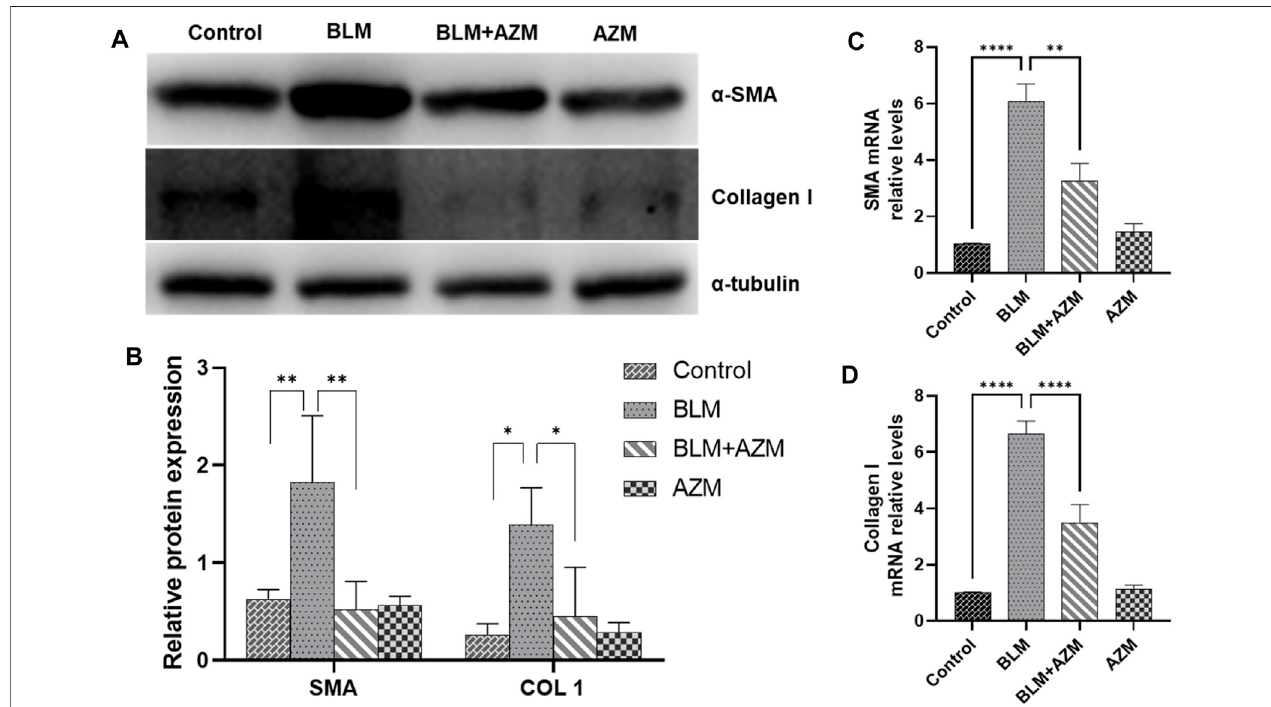
FIGURE 2 | AZM reduced the expression of alpha-smooth muscle actin ( α -SMA) and Collagen 1 (COL 1) in lung tissue of mice with pulmonary fi brosis. (A,B) The proteinexpressionof α -SMAandCOL1wasmeasuredineachgroupbyWesternblot. (C,D) Thegeneexpressionof α -SMAandCOL1wasmeasuredineachgroupby RT-PCR. Data were presented as the means ± SD ( n ≥ 3). * p < 0.05, ** p < 0.01, **** p < 0.0001.